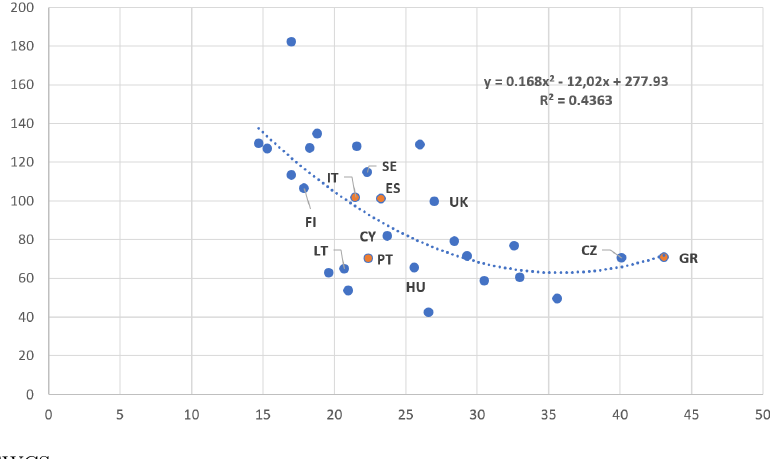
Figure 5: Relation between productivity ( y -axis) and overloaded workers ( x -axis), 2015